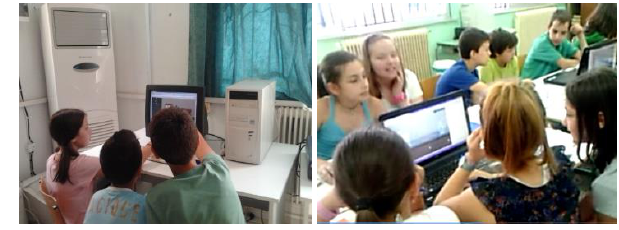
Figure 1. 6 th grade learners working on the sorting puzzle at the 1th Primary School of Volos in small independent groups (left); 5 th grade learners working on the volume measurement puzzle at the 11 th Primary School of Volos in small groups seated in a round table (right).